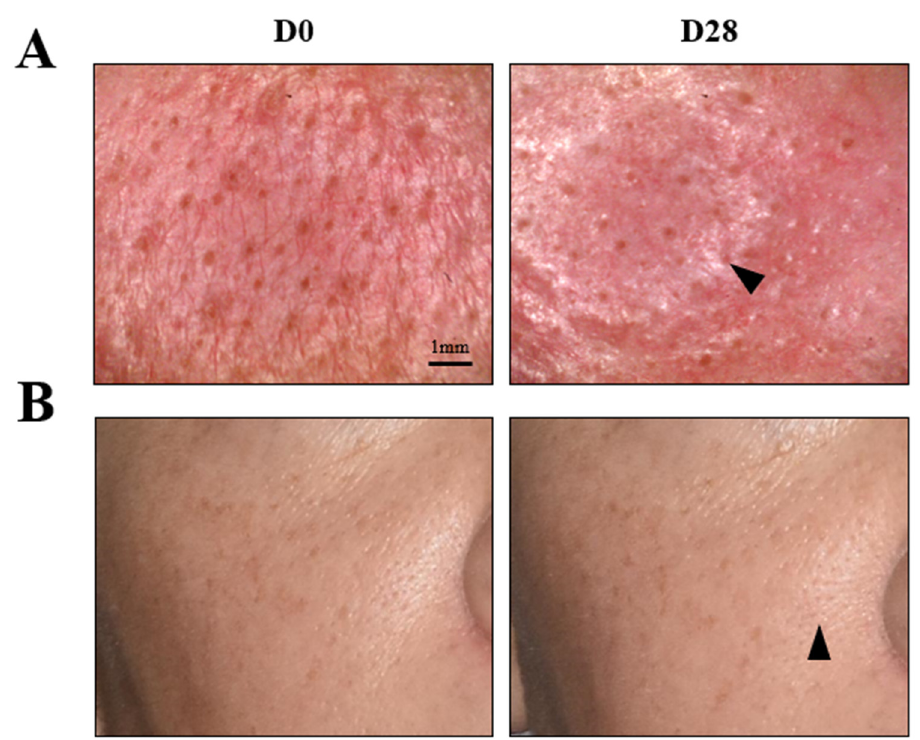
Figure 9. Pore assessment in the nasal wing area at baseline D0 and D28; representative image of the mean pore diameter. ( A ) Visualization of pores using a microscope ( × 30 magnifications). Scale bar: 1 mm. ( B ) Image of a subject representative of the mean pore diameter at D28. Arrows indicate an improvement in the appearance of pores.